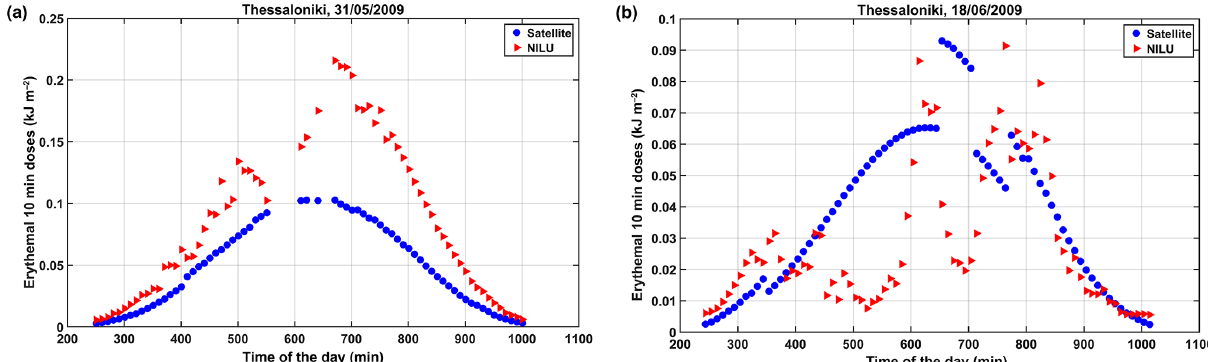
Figure 8. The evolution of the 10min erythemal dose over the day as provided by satellite (blue circles) and at the ground (red triangles) for two days in 2009 showing a large temporal variability in cloudiness. The satellite-derived UV daily dose is lower than the NILU103-derived UV dose by 23% for the case on 30 May 2009 (left panel), while it is larger by 120% for the case on 18 June 2009 (right